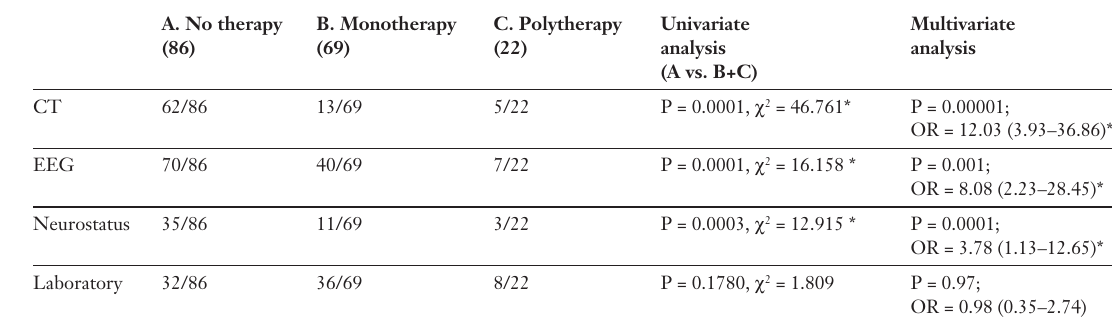
Rate of normal com- plementary examina- tions at D0 (day of the first seizure) di- vided by recurrence, death and absence of recurrence at six months’ follow-up. The table includes only patients who completed follow-up. Note: the 5 CT not performed were considered normal CT scans.